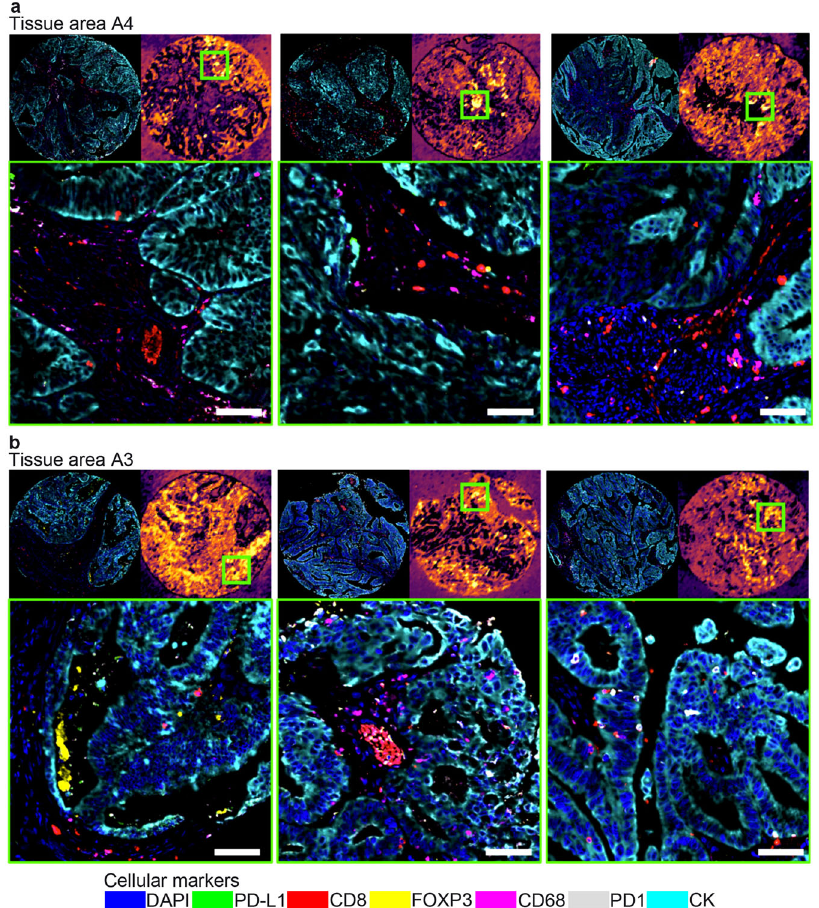
Fig. 6 Visualization of tissue areas. a Top-3 tumor core images assigned to tissue area A4, which is associated with tumors with recurrence. For each one of the representative panel of images: the top left image shows the whole tumor core, the top right image shows the image patch con fi dence when assigning to tissue area, the bottom image shows a tumor region with the highest relevant information from tissue area A4 (more associated with tumors with recurrence). Tissue area A4 shows immune cell in fi ltration located in the stromal compartment, representing “ nonin fl amed ” or “ cold tumors ” . b Top-3 tumor core images assigned to tissue area A3, which is associated with tumors with no recurrence. For each one of the representative panel of images: the top left image shows the whole tumor core, the top right image shows the image patch con fi dence when assigning to tissue area, the bottom image shows a tumor region with the highest relevant information from the tissue area A3 (more associated with tumors with no recurrence). Tissue area A3 shows high immune cell in fi ltration located in the intra- tumor compartment, representing “ in fl amed ” or “ hot tumors ” . Scale bars, 100 μ